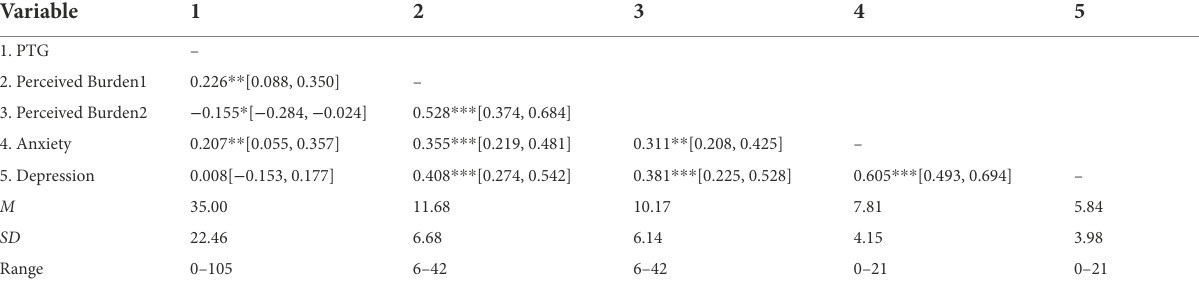
TABLE 1 Means, standard deviations, and correlations coefficients between PTG, depression, anxiety, and burdensomeness (waves 1 and 2).